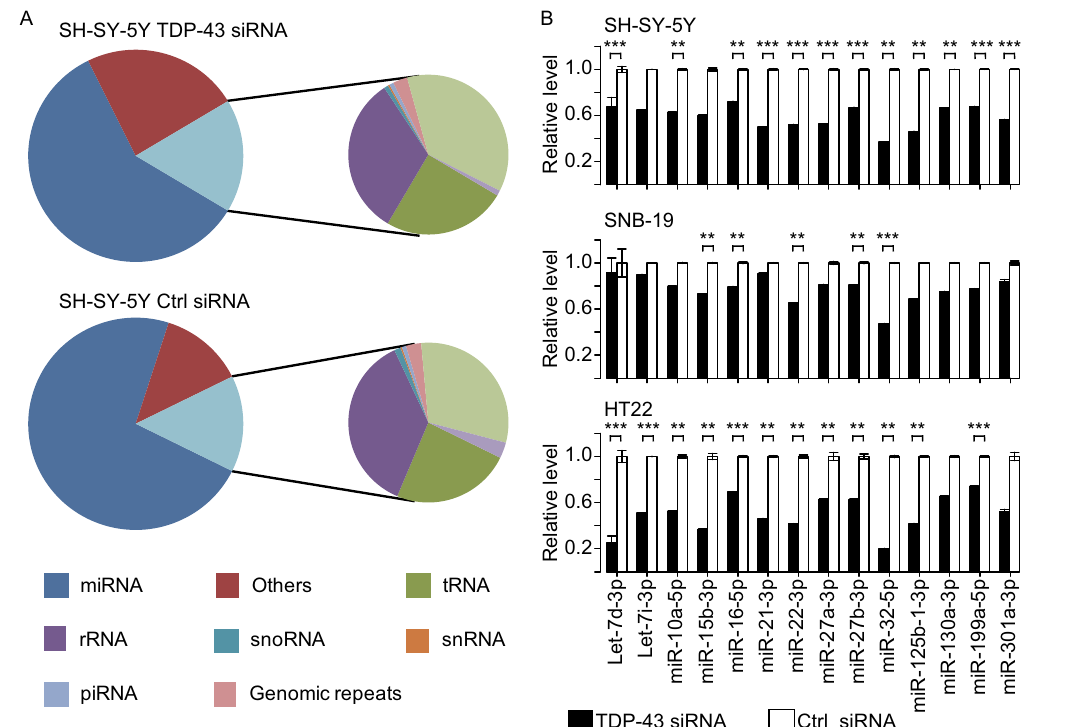
Figure 1. RNA-seq analyses of TDP-43 regulated miRNAs. Reads annotation and validation of small RNA sequencing in TDP-43 and control knockdown libraries. (A) Distribution of small RNA sequencing reads mapped to the human genome in SH-SY-5Y cells. Components of TDP-43 knockdown small RNA library (upper) and control library (bottom) are shown. (B) qRT-PCR of miRNAs that were differentially expressed following TDP-43 knockdown. The expression levels of mature miRNAs in SH-SY-5Y (upper panel), SNB-19 (middle), and HT22 (bottom) cells transfected with either TDP-43 siRNA or control ( n = 3). Statistical analyses were performed using t -test. ** P < 0.05; *** P <